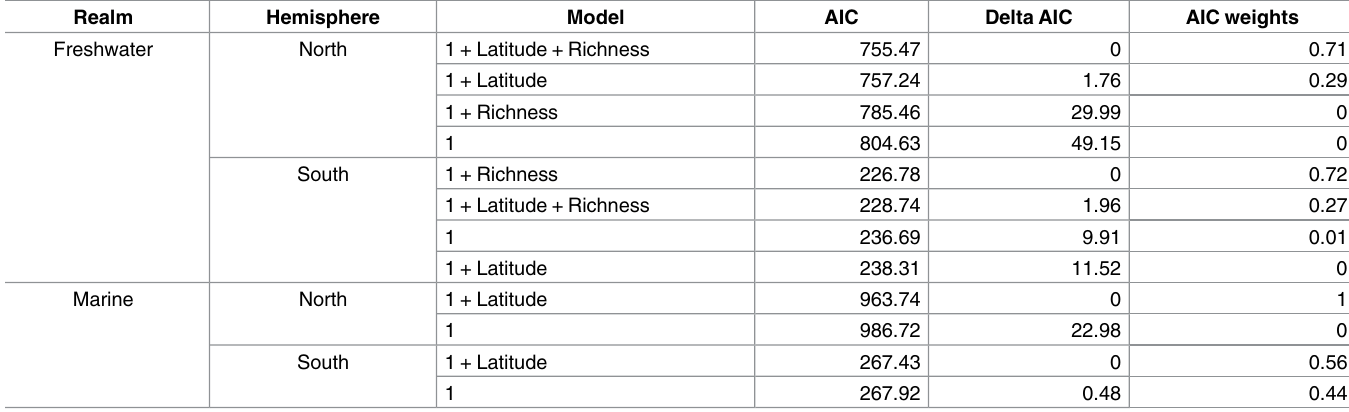
Table 1. Best models (GLMM) for the occurrence of cannibalism for both freshwaterand marine realm in Northern and Southern hemispheres. Realm